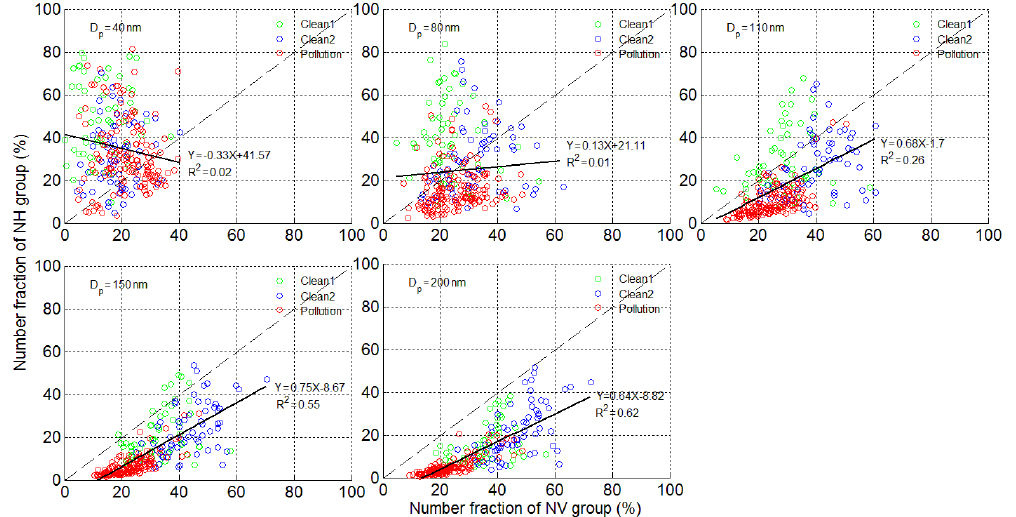
Figure 8. Comparisons between the number fractions of the nearly hydrophobic group (NF NH ) and the nonvolatile group (NF NV ) for the Clean1 (in green), Clean2 (in blue), and Pollution (in red) periods at the Beijing site (26 August–6 October